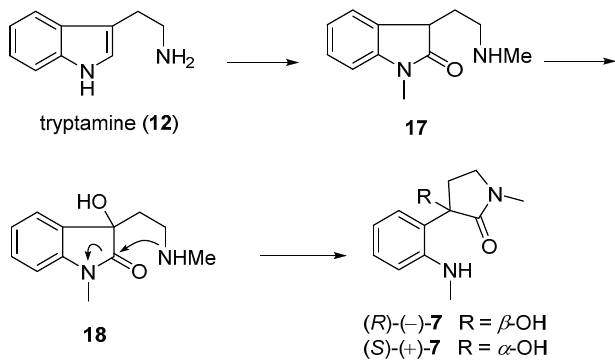
Scheme 2. Potential biogenetic pathway of chimonamidine ( 7